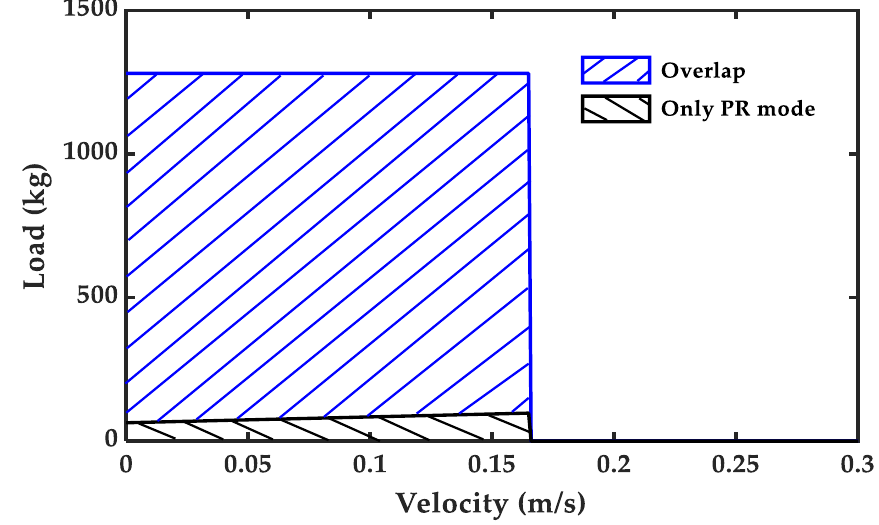
Figure 9. The load-velocity curve for switching mode on retraction mode of NIMV system.